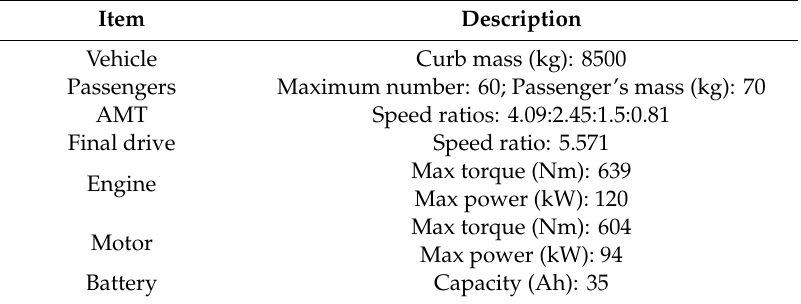
Table 1. The parameters of the PHEB. AMT: automated mechanical transmission.